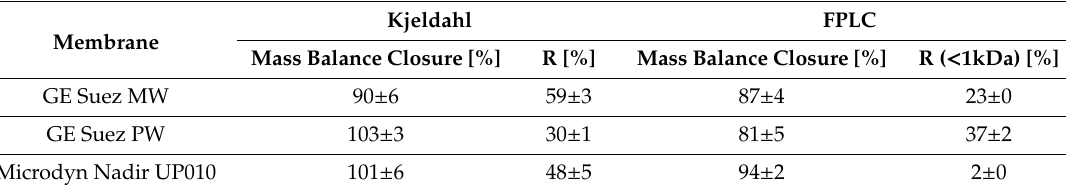
Table 6. Membrane processing of codfish blood: mass balance of total protein / peptides by Kjeldahl and the FPLC methods, the observed rejection of total protein / peptides by Kjeldahl method, and the observed rejection of peptides (with MWs < 1 kDa) by the FPLC